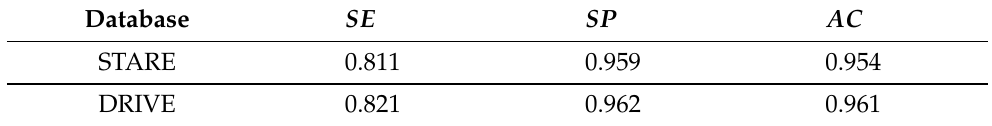
Table 1. Performance Evaluations on the STARE and DRIVE Datasets.